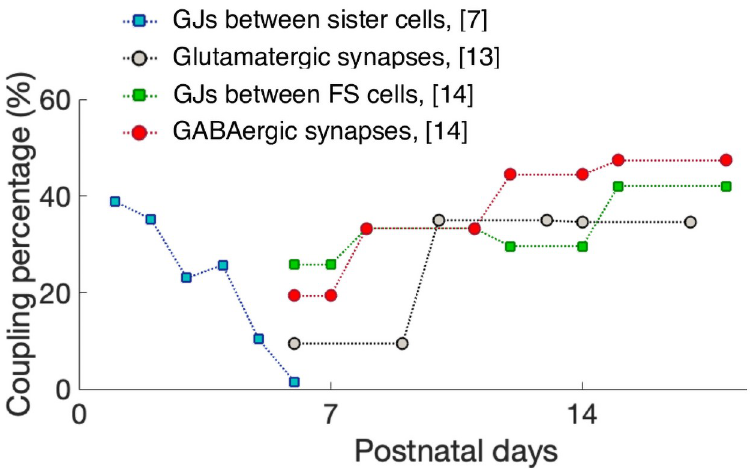
Fig 1. Different percentages of couplings over the first few postnatal weeks. The coupling probability for glutamatergic synapses is measured for radially-aligned sister cells only, while the GJs and GABAergic synapses are measured between fast-spiking (FS) cells. The experimental data was often reported as an average over several days, represented here as horizontal lines.